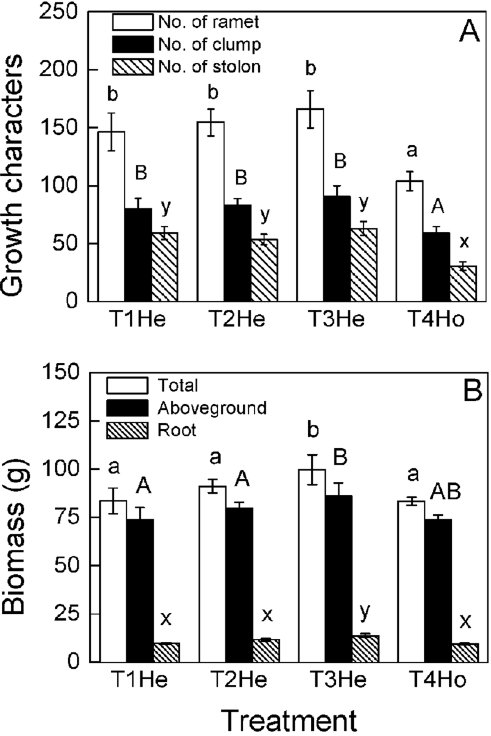
Figure 6. Different responses of growth characters of Buchloe dactyloides among heterogeneous patches of different nutrient treatments at clonal fragment level. The growth characters include number of ramets, clumps, stolons (A) and biomass (B). Bars are mean values ( 6 S. E.). Bars sharing the same letters are not different at p =0.05. Treatment codes are in Figure 1.